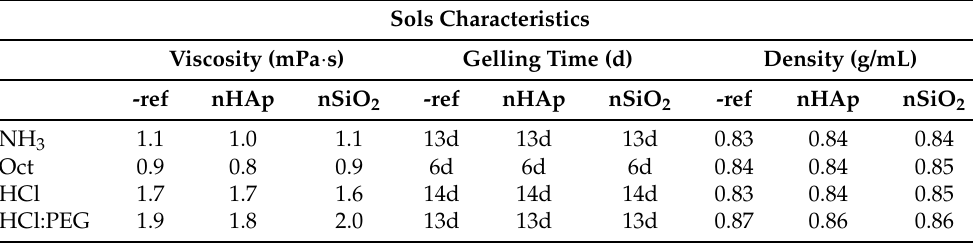
Table 2. Characterisation of the formulations’ properties: viscosity (mPa · s) at 24.5 °C, approximate gelling time (in d), and density (g/mL).